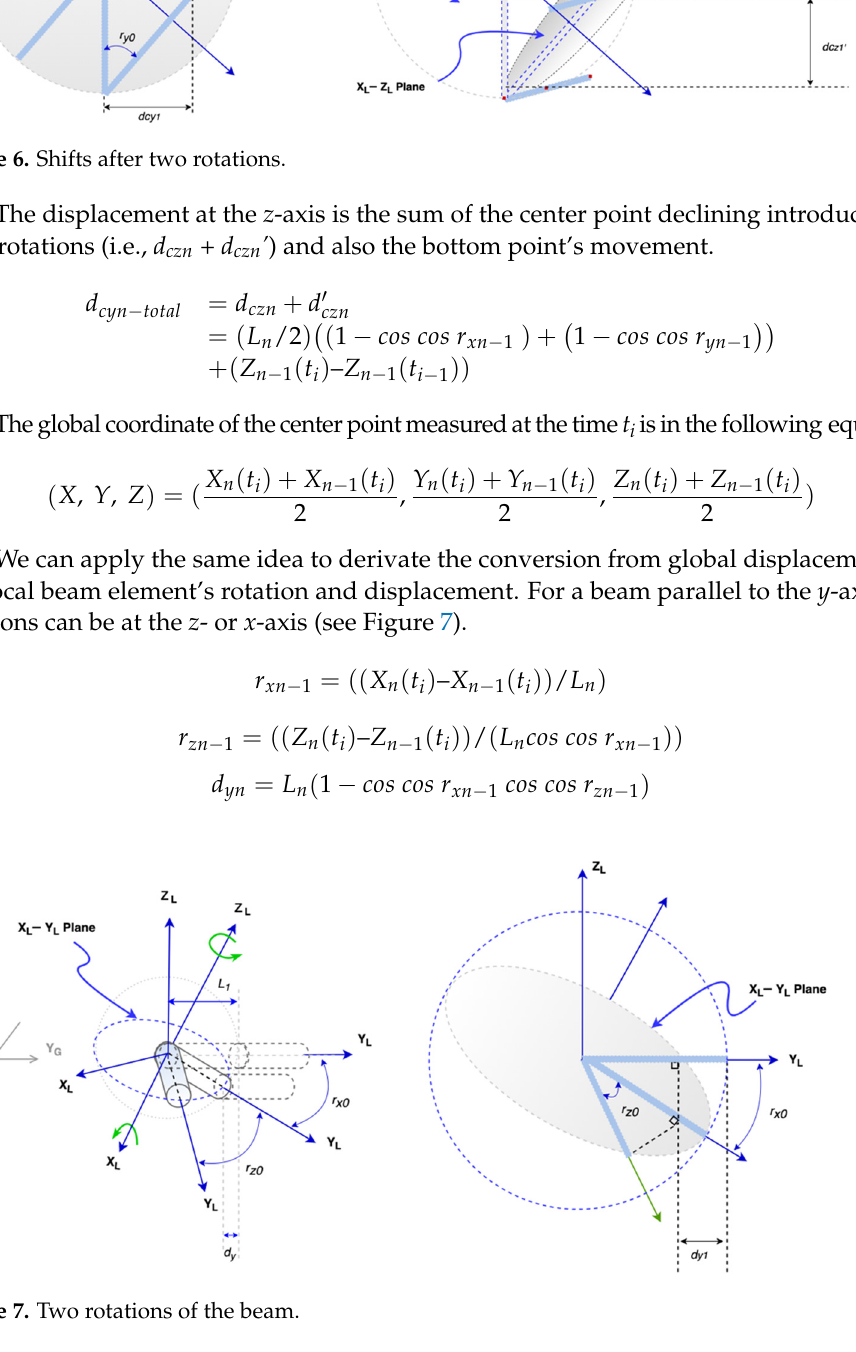
Figure 7. Two rotations of the beam.